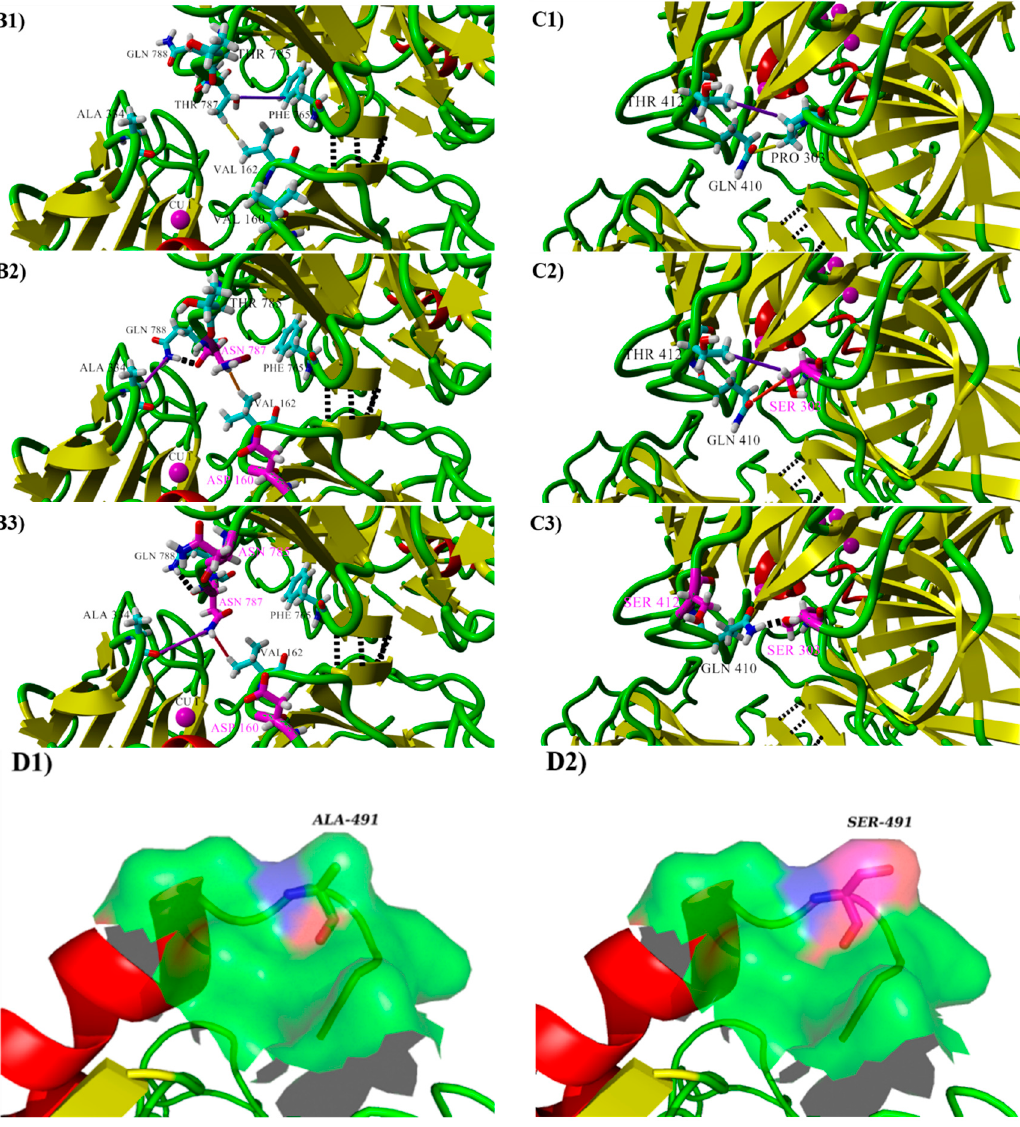
Figure 6. Location of different residues in the parent laccase and the mutants introduced by directed evolution. Protein model of the parent laccase based on homodimeric laccase 3X1B ( A1 ). Solvent accessible surface of the LacA homodimer. The yellow arrow points at the substrate entrance. ( A2 ). Details of the mutation complex (in magenta) in variants ( B2 , B3 , C2 , C3 , D2 ) compared with the corresponding residues in the native laccase ( B1 , C1 , D1 ). Magenta spheres represent Cu atoms. The vdW interactions are shown as yellow, blue, red, and purple sticks. H-bonds are shown as black dashes.